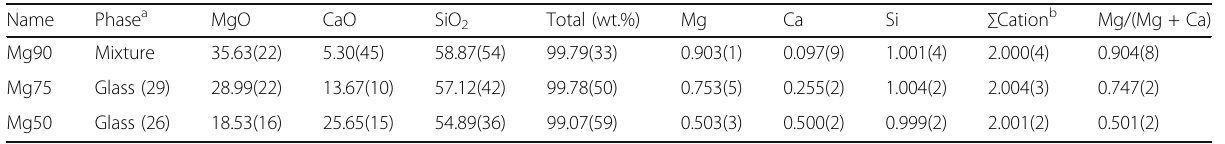
Table 1 Chemical compositions of starting